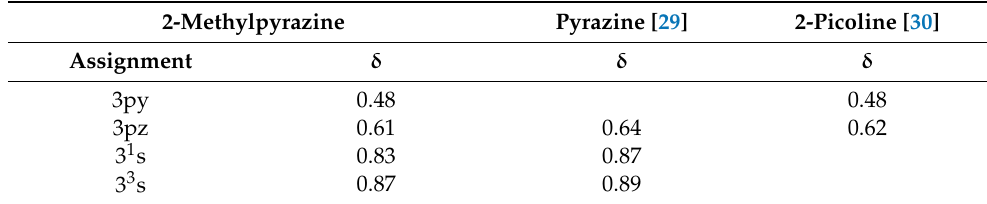
Table 2. Assignments of Rydberg states for 2-methylpyrazine, pyrazine and 2-Picoline.